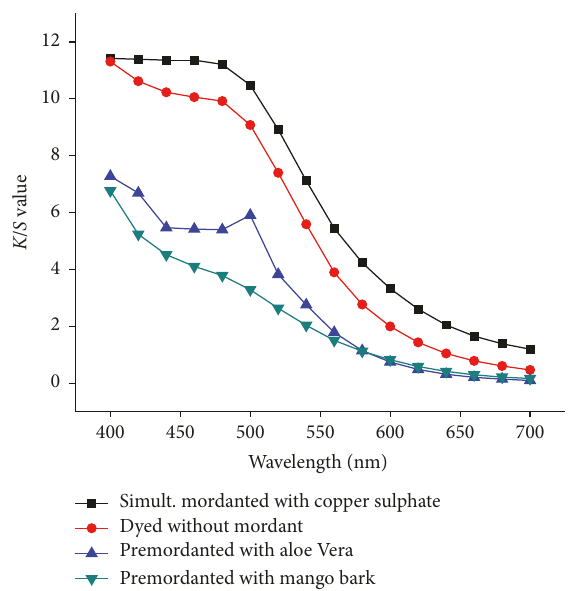
Figure 1: Effect of mordant and pH on 𝐾/𝑆 of dyed leather